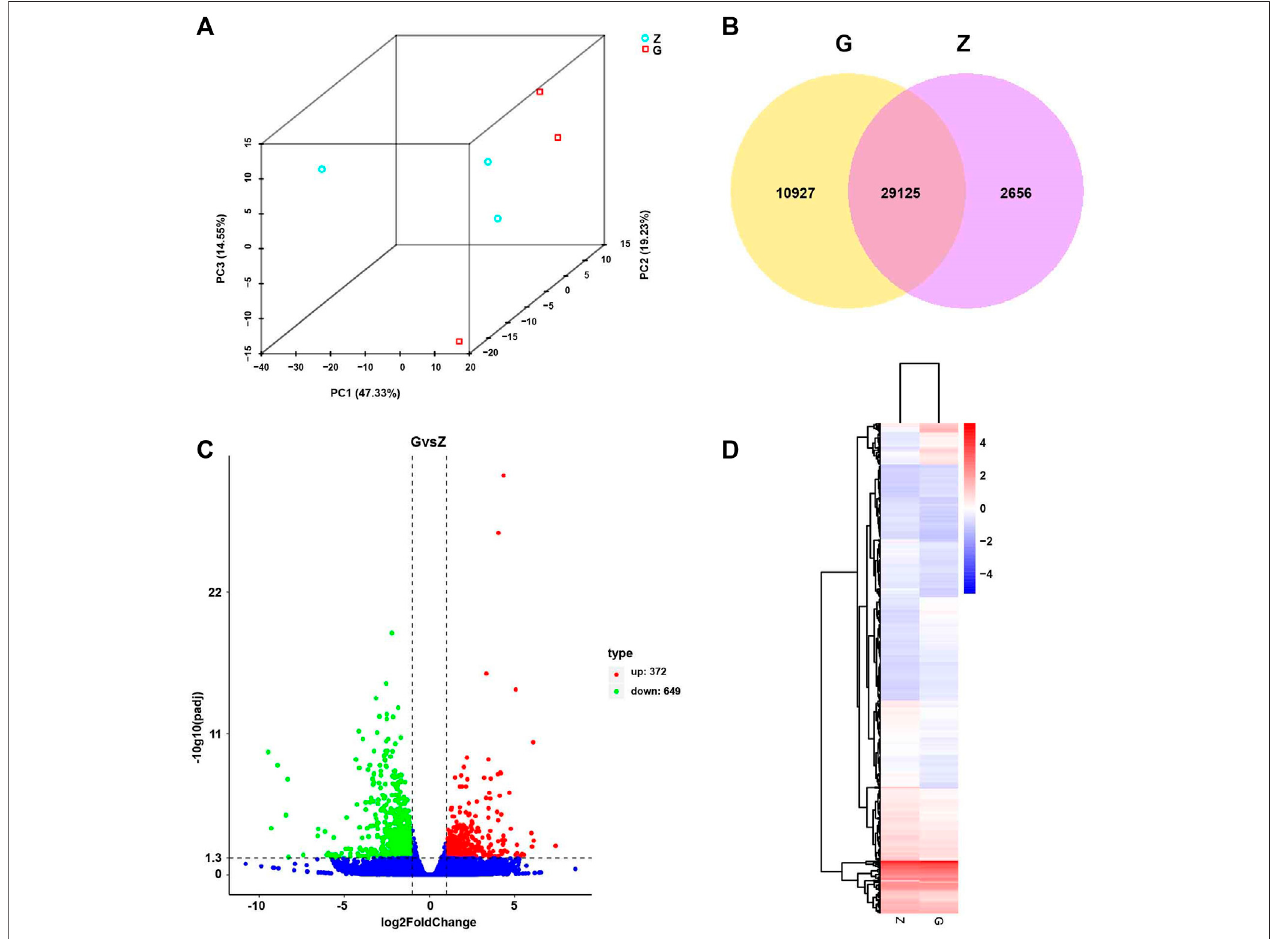
FIGURE 7 | Principal Component Analysis (PCA), Differential Expression (DE) analysis, and Hierarchical Clustering (HC) of fed with high starch diet (G) compared with fed with free-starch diet (Z). (A) PCA analysis of all samples showed a clear separation between group Z and group G along PC1. (B) Venn diagram of unique and shared genes. (C) VolcanoplotofdifferentialgenesingroupGcomparedwithgroupZ.Reddotsrepresent upregulatedgenesandgreendotsrepresentdownregulated genes. (D) Hierarchical clustering (HC) analysis of differential genes in group Z and group G. High expression is shown in red and low expression in blue.